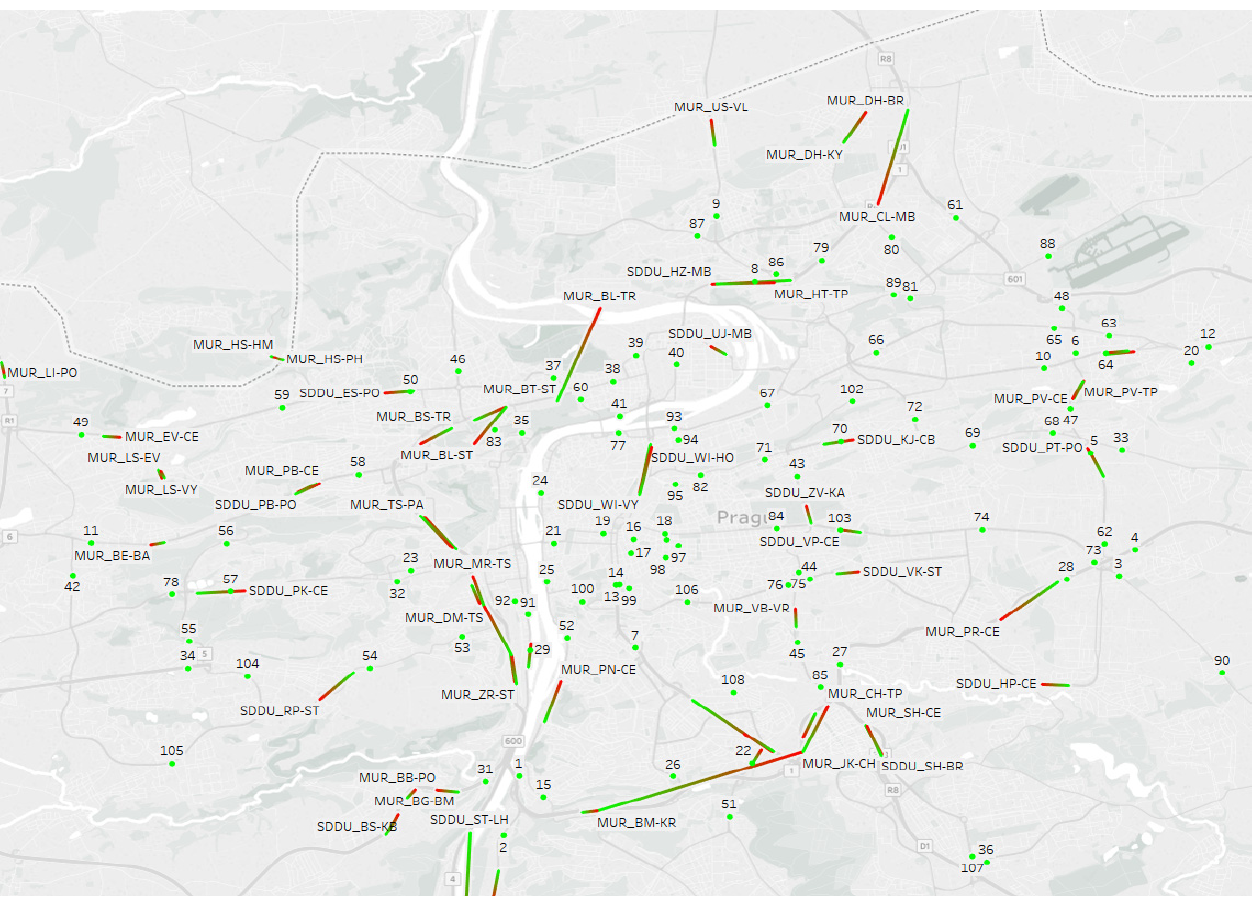
Figure 2. Overview of strategic sensors located in Prague and used within the project GLOMODO.